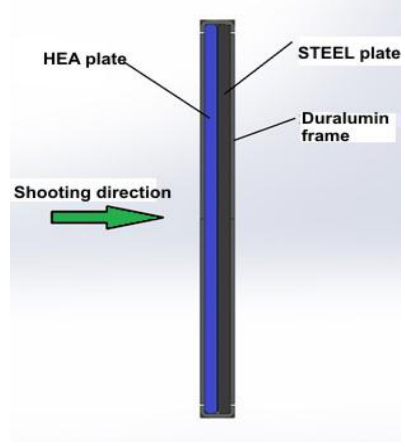
Figure 8. The shooting scheme for structure 1.